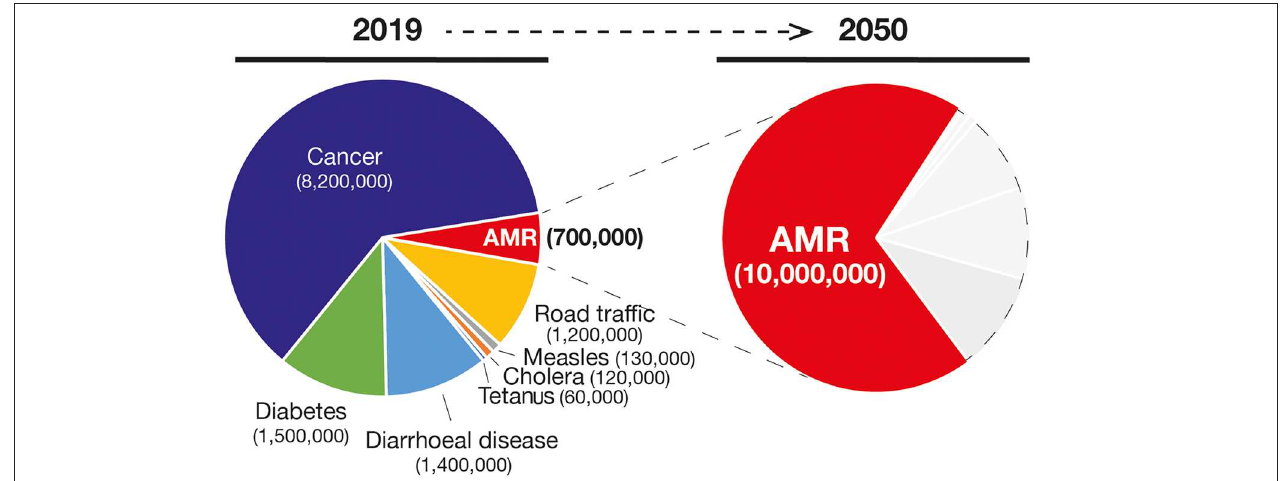
FIGURE 2 | Number of deaths and the main causes (Left) in 2019 and the projection of number of deaths due to AMR infections in 2050 (in red in the Right ). Gray areas represent other causes of